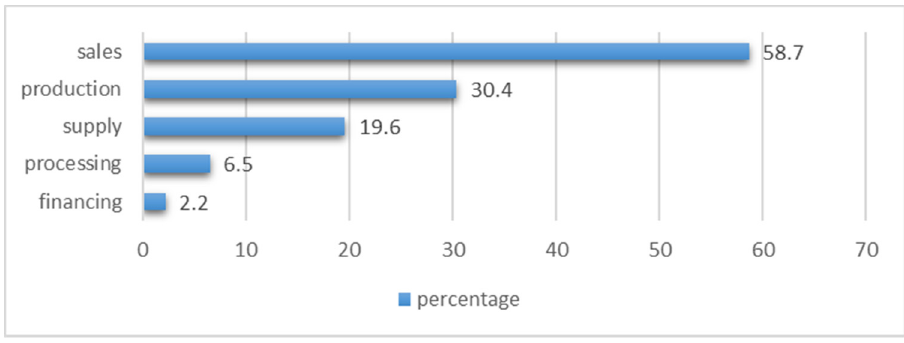
Figure 5. Key focus of associations (Source: own research).